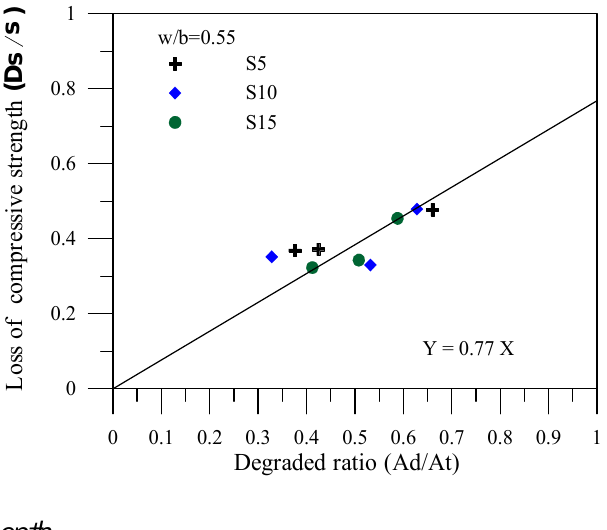
Figure 9. Correlation between the degradation area and the compressive strength loss for the specimens with silica